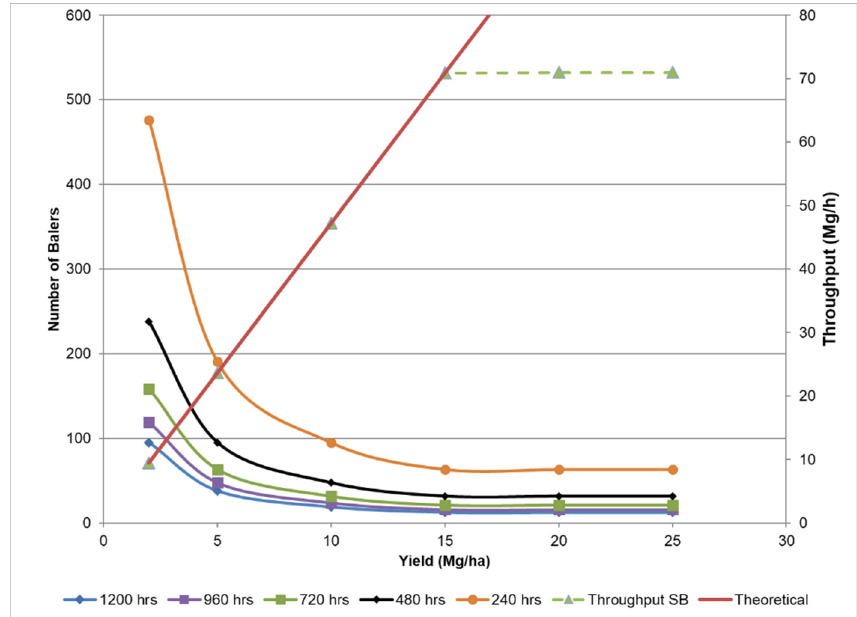
Figure 6. The impact of the number of large-square balers required to supply a 3000 Mg/day biorefinery. The solid red line is the theoretical capacity of the baler (no consideration of design maximum throughput) and the dashed line is the baler-achieved throughput after accounting for throughput restrictions.